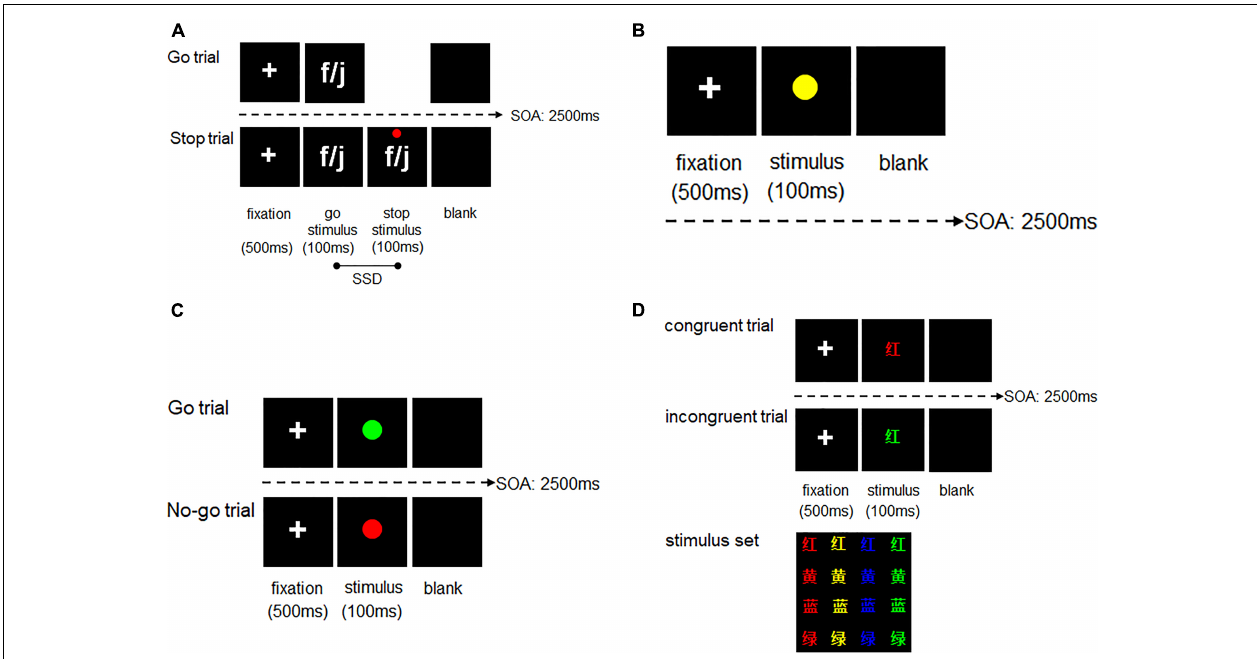
FIGURE 2 | (A) SST design in the training session of the current study. (B) SRT design in the training session of the current study. (C) Go/No-go task design in the pre- and post-training tests of the current study. (D) Color-word Stroop task design in the pre- and post-training tests of the current study; “ ,” “ ,” “ ,” and “ ” separately represent “red,” “yellow,” “blue,” and